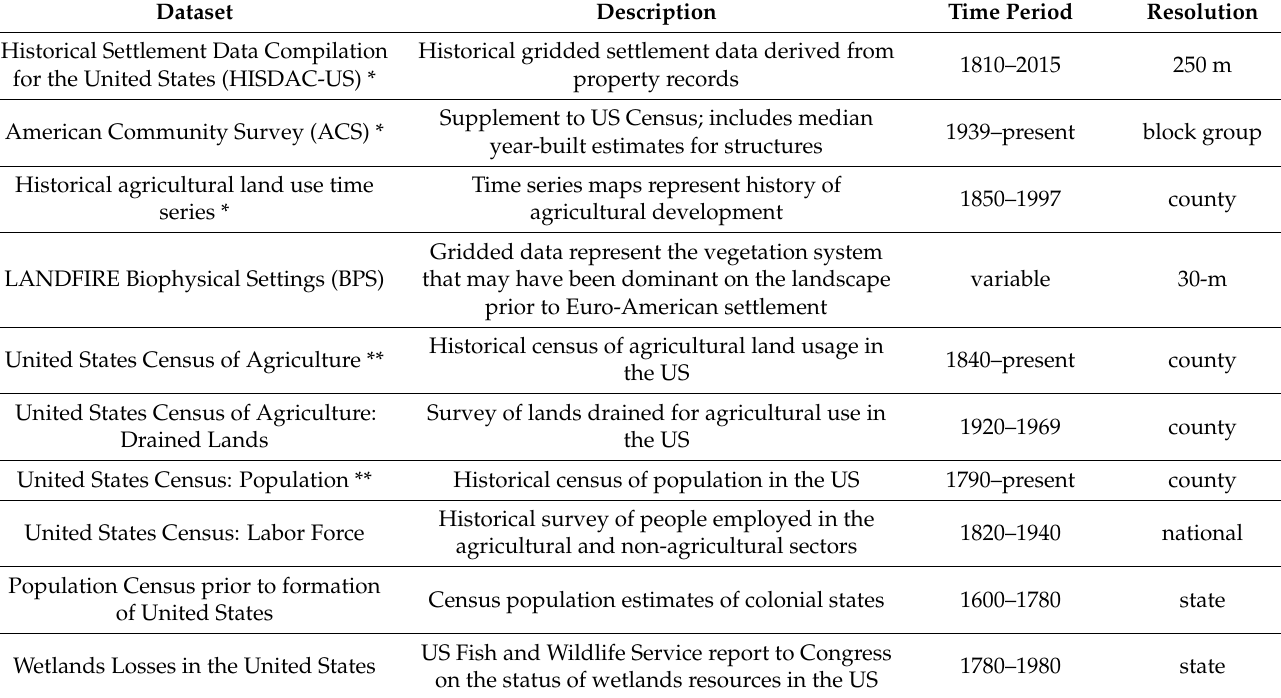
Table A1. Datasets used in FORE-SCE’s historical reconstruction.